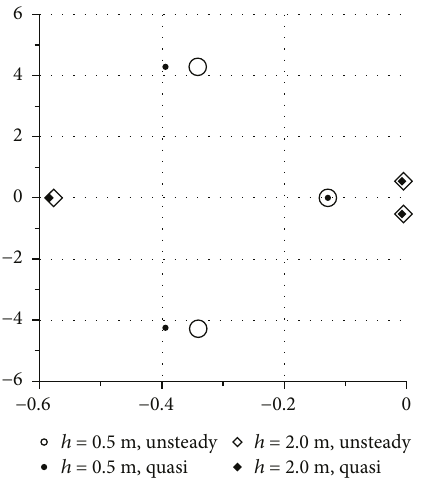
Figure 13: Locus of three fi rst roots of the WIG craft at two heights of fl ight obtained under unsteady and quasi-steady aerodynamic